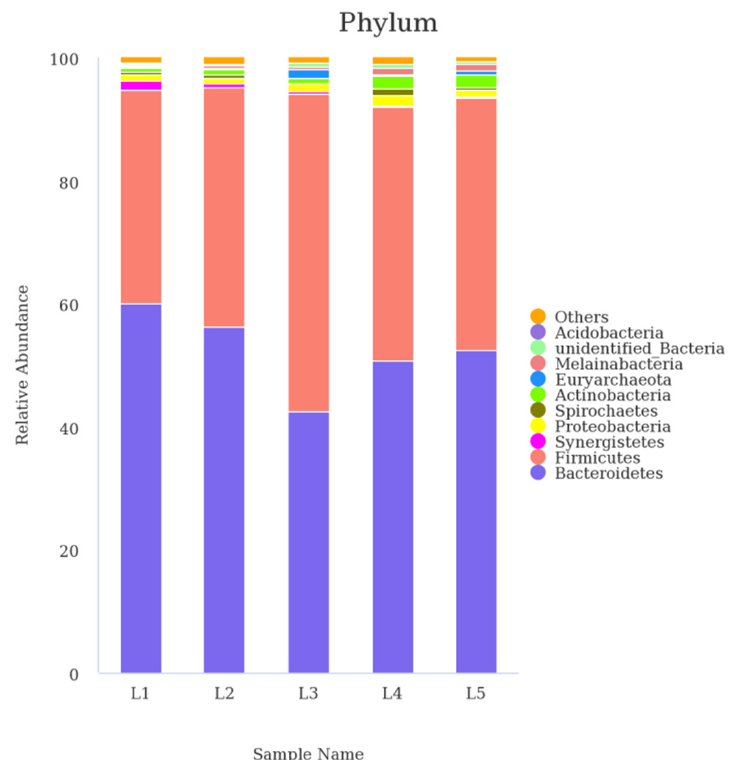
Figure 2. The column chart of the main dominant phylum (only the top 10 abundant phyla are presented). L1, L2, L3, L4, and L5 represent five groups of lambs treated with dietary alfalfa (AF) ratio at 0%, 20%, 40%, 60%, and 80% in the alfalfa–sweet sorghum (AF–SS) silage mixtures; n = 3 for each group.